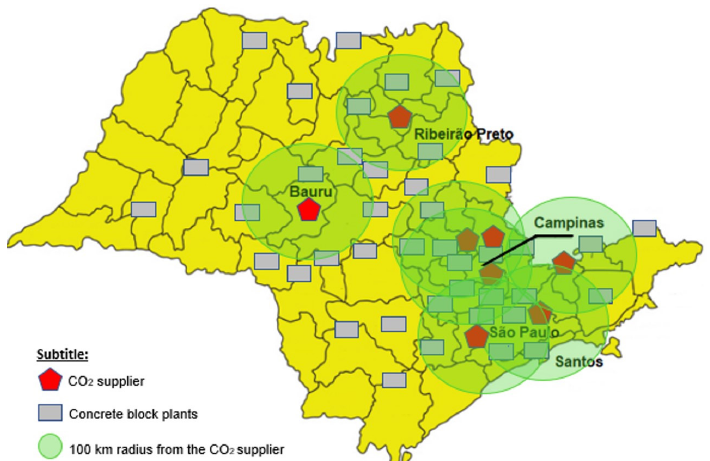
Figure 14. Radius of 100 km for CO 2 distribution. Source: Author (2022).